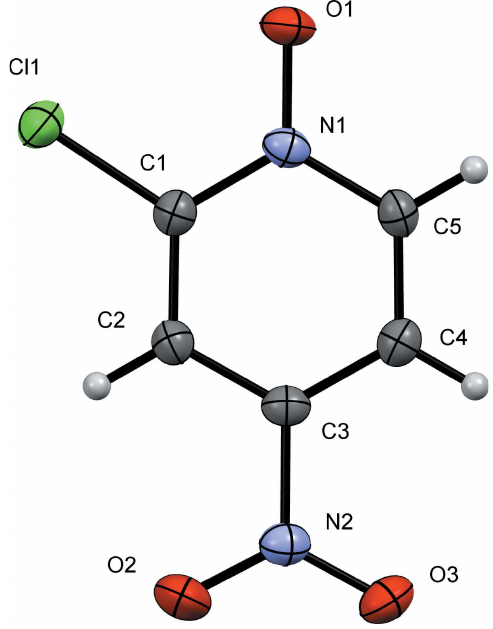
Figure 1 A view of the molecular structure of the title compound, with the atom labelling. Displacement ellipsoids are drawn at the 50% probability level.